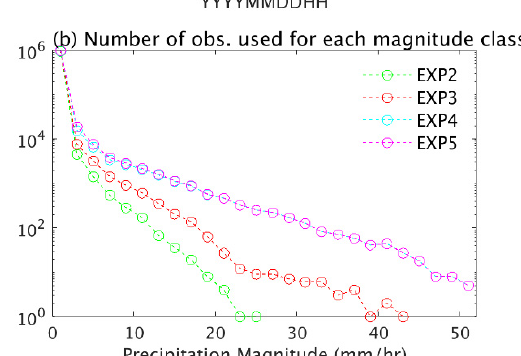
Figure 7. ( a ) Fraction of observations used in each assimilation experiment to the total available observations at each hour. ( b ) Number of observations used for all the hours at di ff erent magnitude classes with 1 mm / h intervals. EXP2 and EXP3 represent experiments with nontransformed and logarithmically transformed precipitation with constant observation error, respectively; EXP4 and EXP5 are as for EXP2 and EXP3, but with increasing observation error with precipitation magnitude.